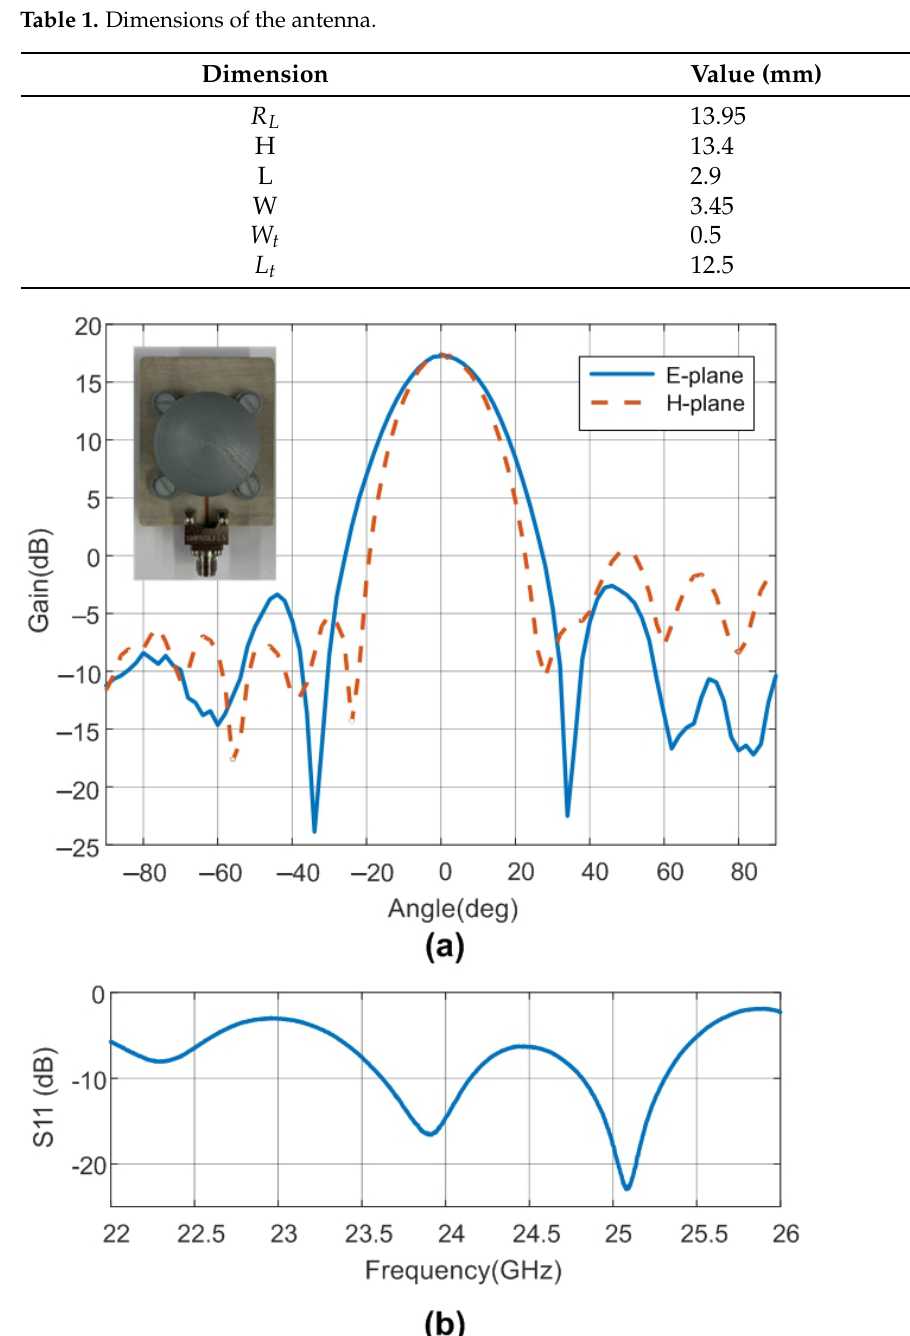
Figure 9. ( a ) Measured gain in the lens antenna (cuts in the E-plane and H-plane). Inset image of the antenna prototype. ( b ) Measured reflection coefficient as a function of the